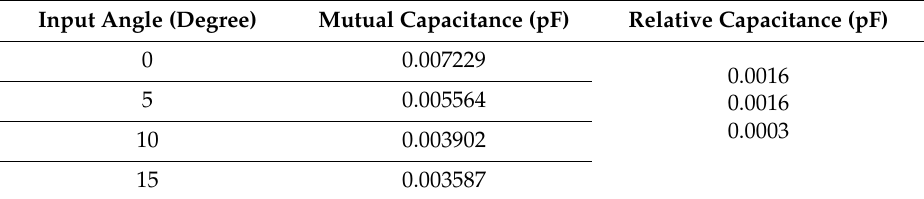
Table 3. The relationship between the angle and the mutual capacitance.